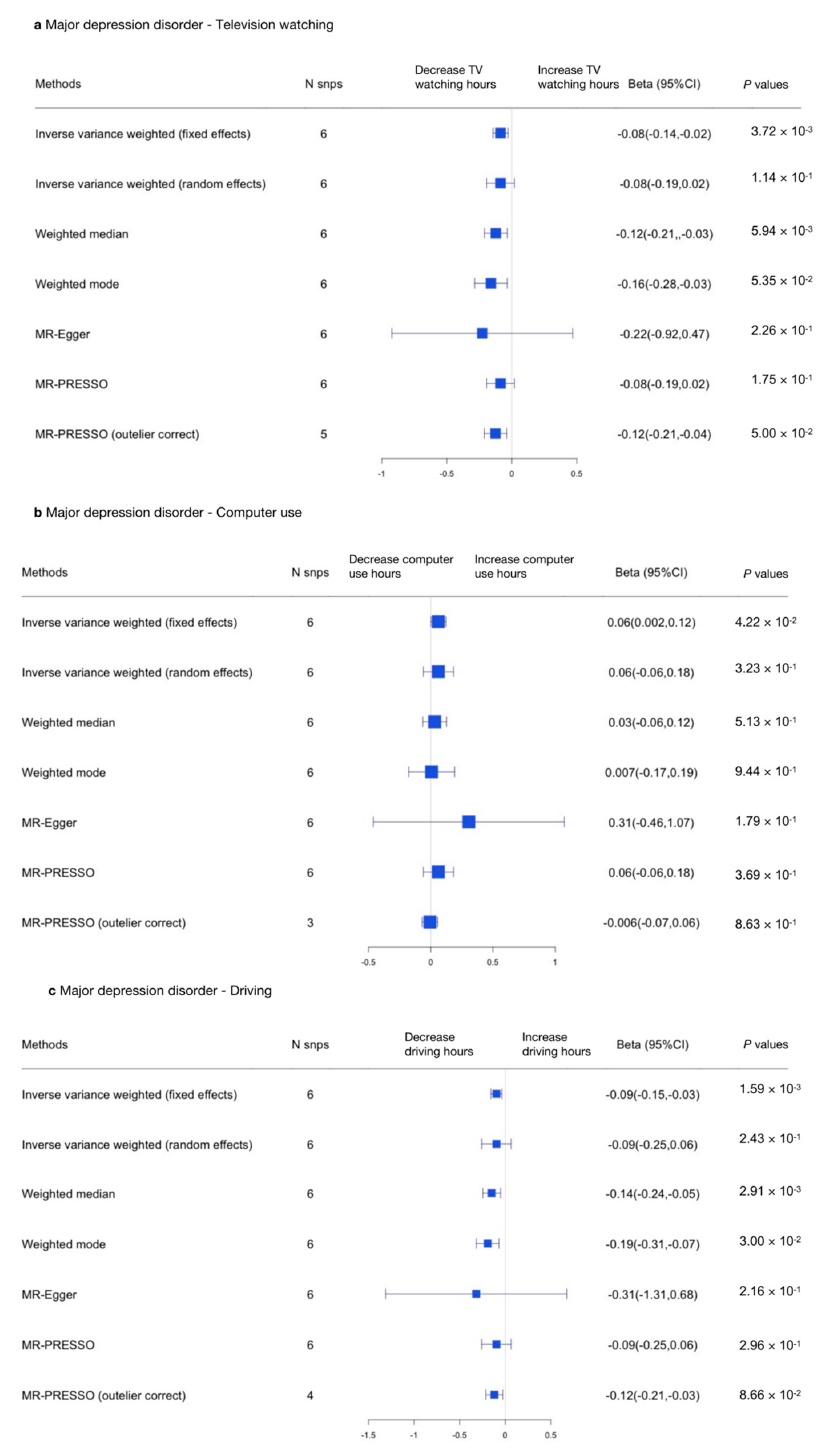
Figure 7. Summarized Mendelian randomization (MR) effect sizes of MDD and sedentary behaviors. Summarized MR effect sizes of the causal relationship between MDD and ( a ) television watching time, ( b ) computer use time, and ( c ) driving time were estimated using the following approach. The methods used in the analyses included IVW, IVW removing genetic variants with a potentially pleiotropic effect in any phenotype, MR-Egger, weighted median, MR pleiotropy residual sum and outlier (MR-PRESSO), outlier-corrected MR-PRESSO, and weighted mode methods. Odds ratios (ORs) as well as 95% confidence intervals (95% CIs) are presented on the x axis. A two-sided p -value of less than 0.05 was considered statistically